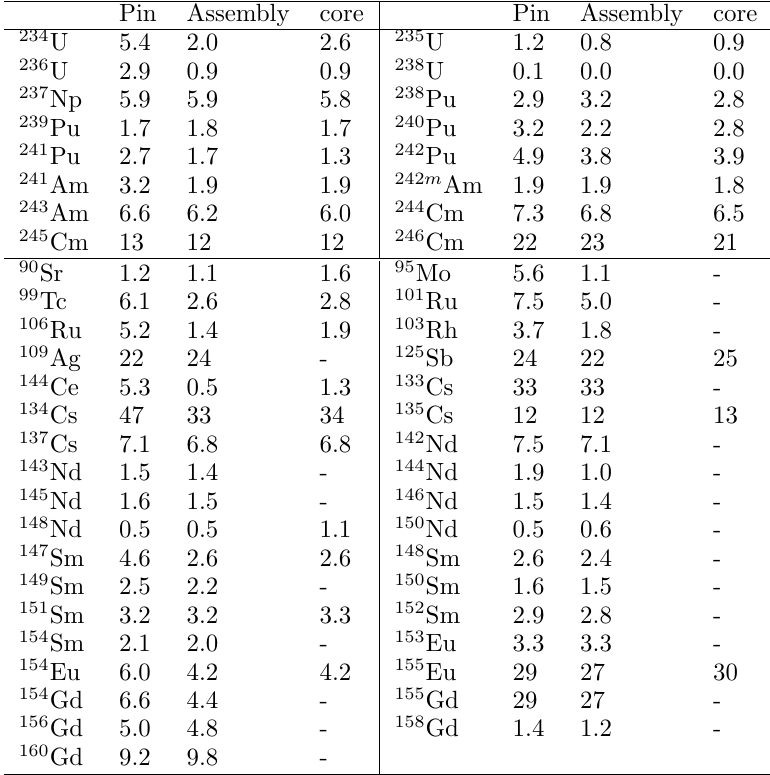
Table B.6. Uncertainties in % at the time of measurement due to the ENDF/B-VIII.0 library with the three models (pin, assembly and core) for the BM1-P sample, based on the CASMO5 v2.03